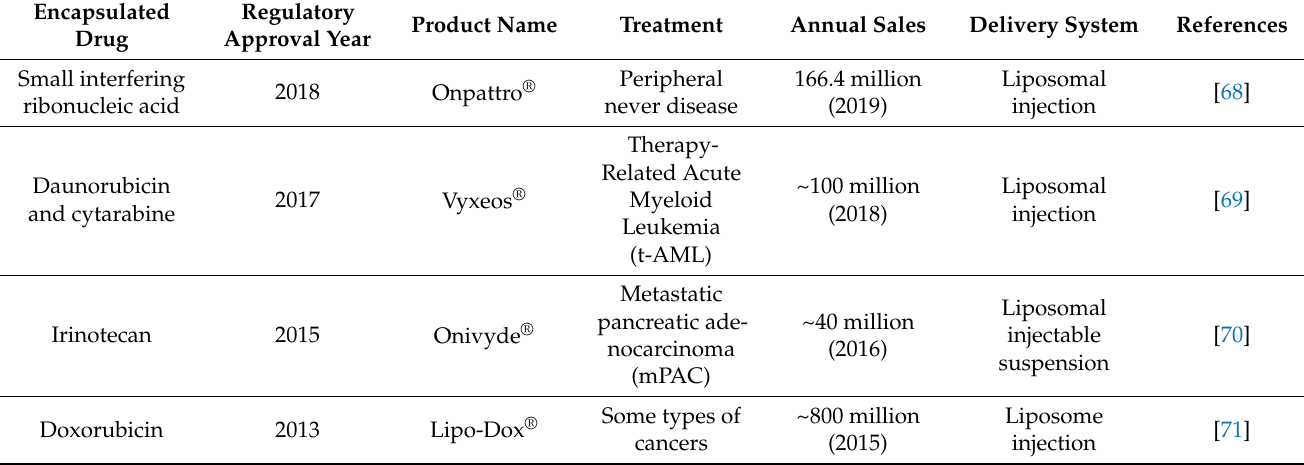
Table 1. Liposome based products on the market and in clinical